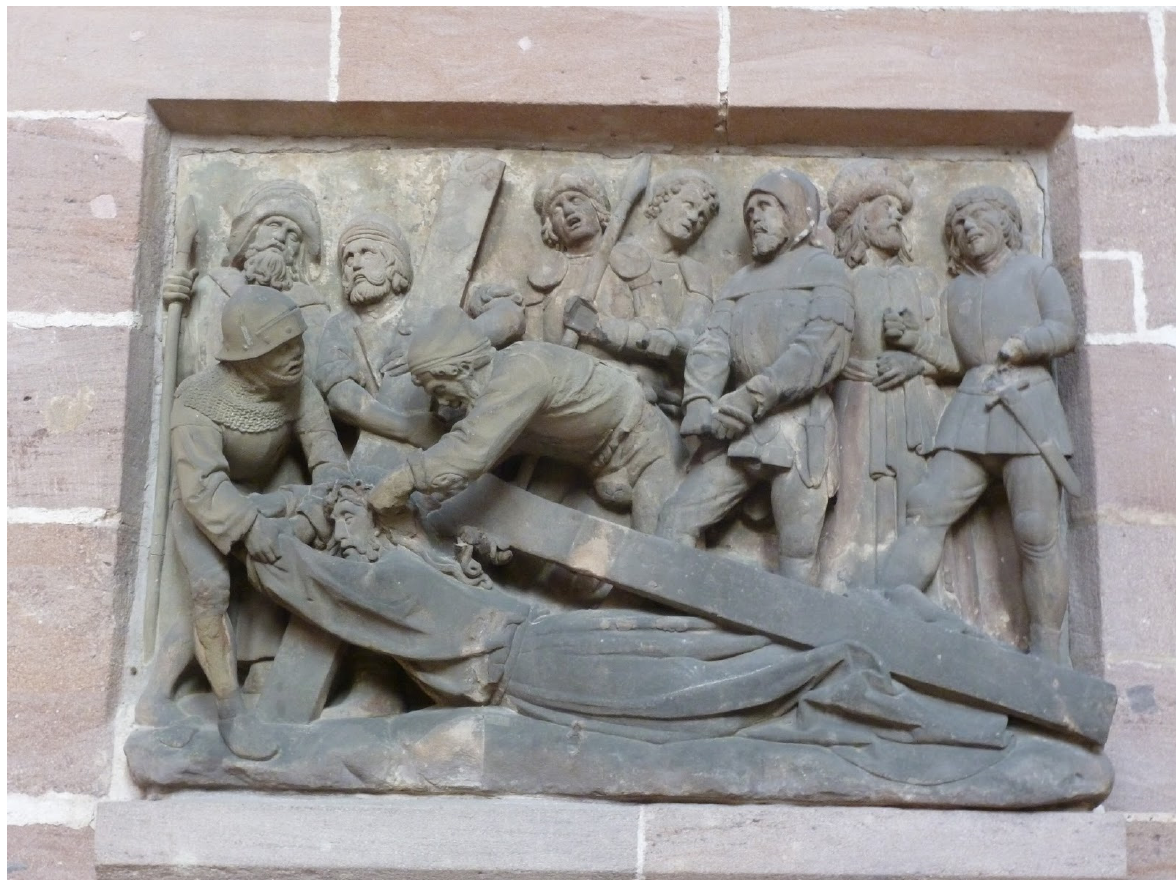
Figure 20. Kraft, Stations of the Cross, Nuremberg, Station Six (Nuremberg, Germanisches National- museum).